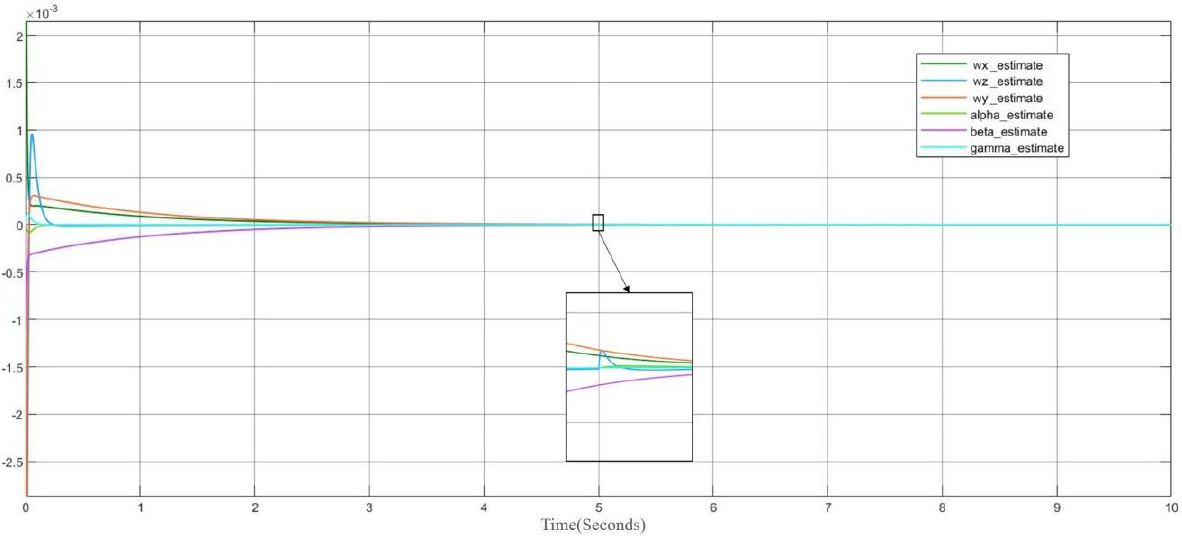
Figure 11. Input 2’s 60% PLOE fault detection simulation.